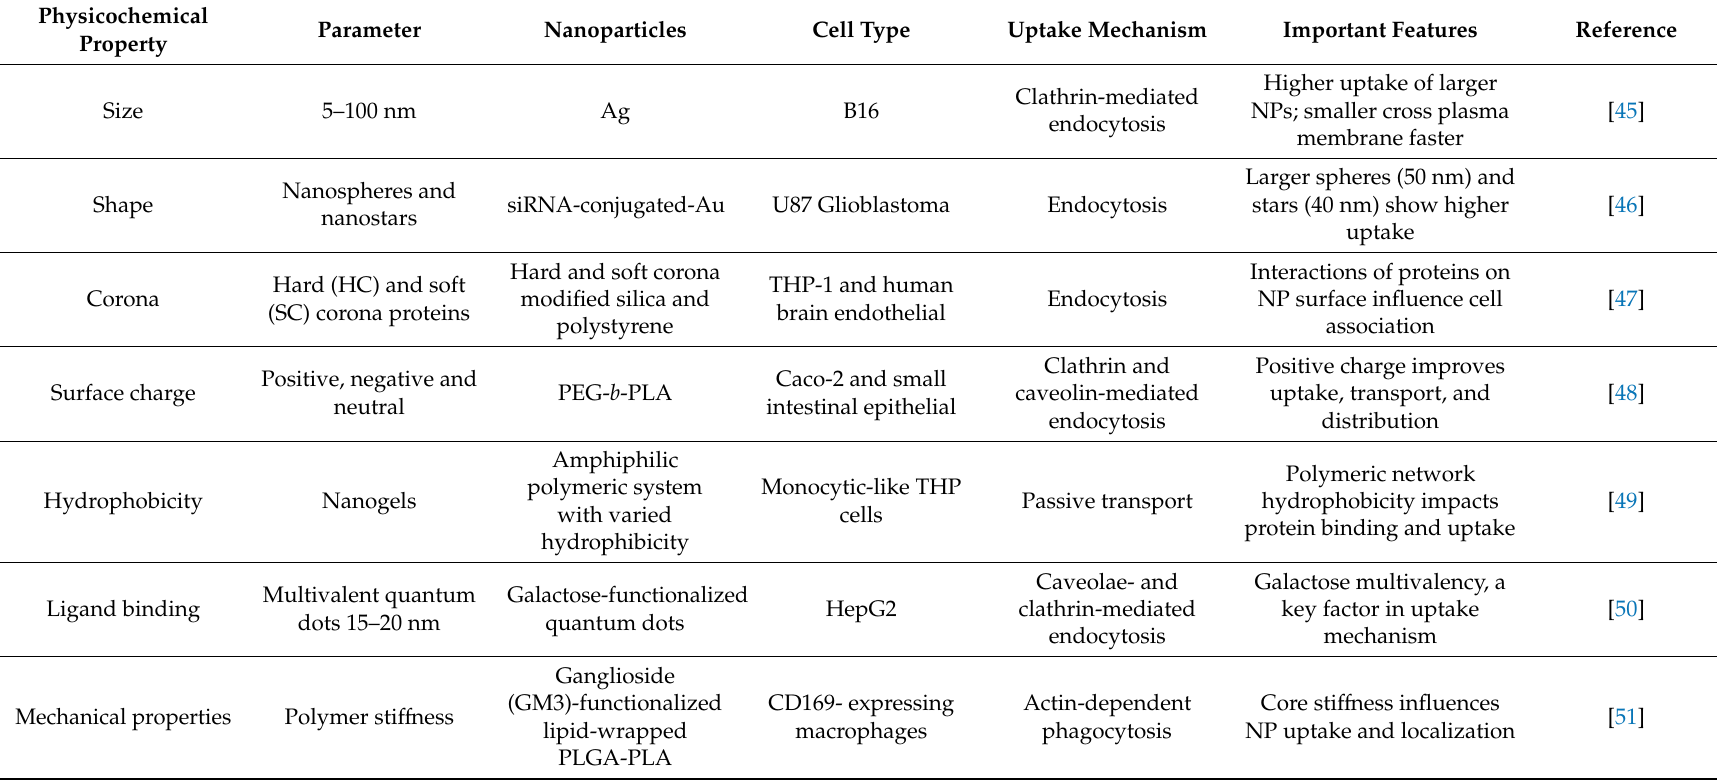
Table 1. Recent studies highlighting the influence of NP physicochemical properties on cellular